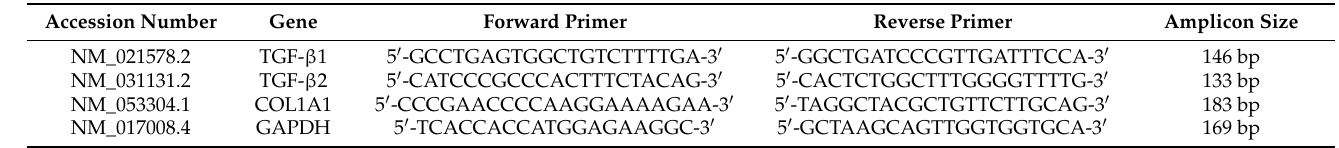
Table 2. Primer sequences for quantitative reverse transcription polymerase chain